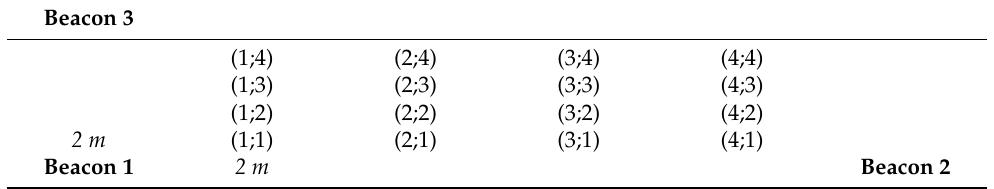
Table 4. Configuration and zoning.